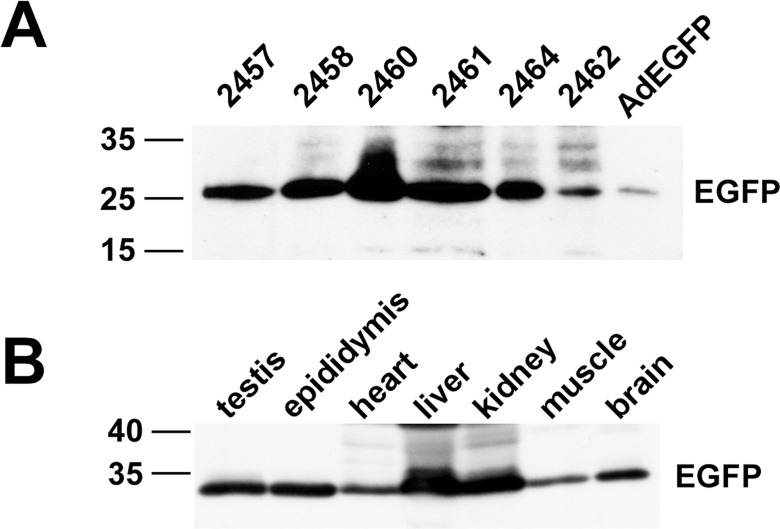
Expression of the AR-EGFP transgene in founder mice.A) Testis whole cell extracts from 6 founder mice having germ line transmission of the AR-GFP transgene and extracts from Cos7 cells infected with an adenovirus expressing EGFP (AdEGFP) by western blot. B) Whole cell extracts from the 2460 founder strain containing the AR-EGFP transgene were assayed for EGFP expression by western blot.